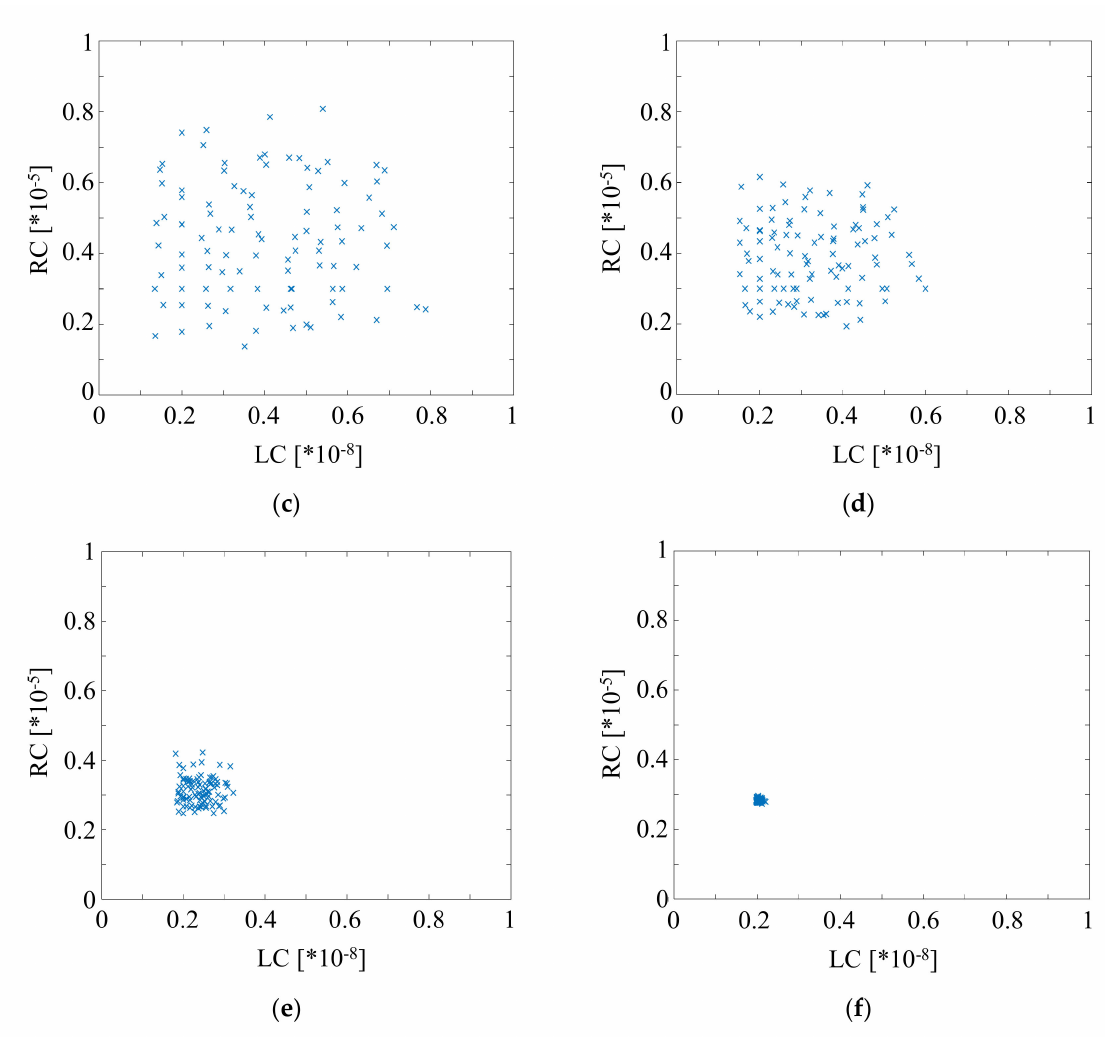
Figure 8. Calculation process of PSO. ( a ) Iteration is 0; ( b ) iteration is 1; ( c ) iteration is 5; ( d ) iteration is 10; ( e ) iteration is 20; and ( f ) iteration